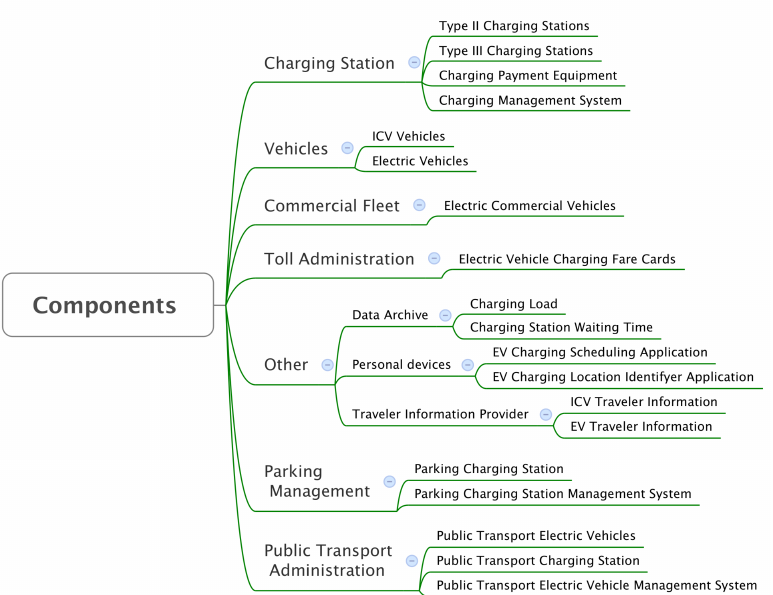
Figure 15. Integration of EVs as new components in Abu Dhabi’s ITES